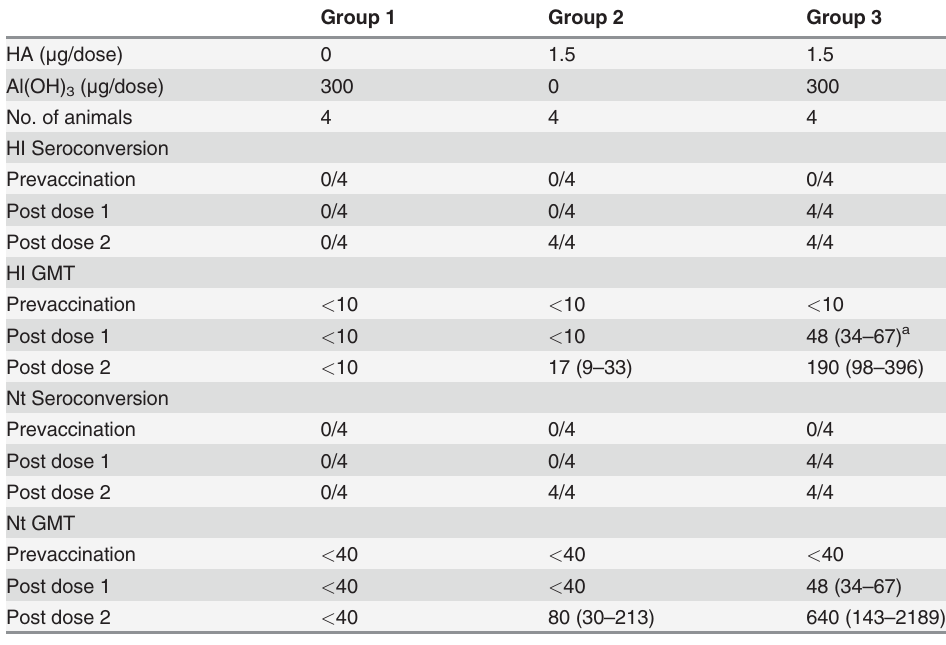
Table 1. Immunogenicity of inactivated in fl uenza H7N9 whole virus vaccine in ferrets. Group 1 Group 2 Group 3 HA ( μ g/dose) 0 1.5